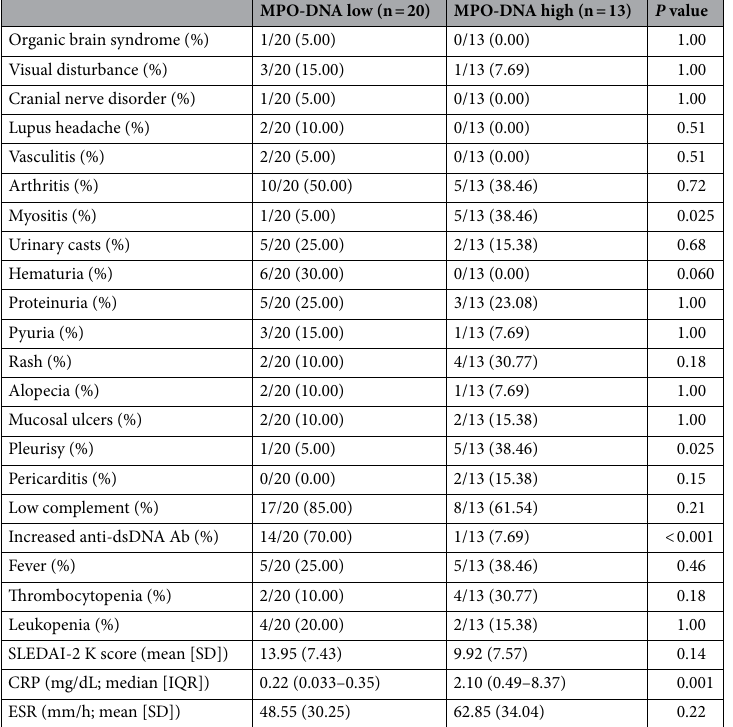
Table 1. Comparison of patients with and without high MPO-DNA complex levels in each SLEDAI-2K variable. The MPO-DNA high group was defined as OD value > 0.62 (mean + 2SD of HC). Group differences in the proportion of categorical variables were analyzed using Fisher’s exact tests. Anti-dsDNA Ab anti-double stranded DNA antibody, CRP C-reactive protein, ESR erythrocyte sedimentation rate, HC healthy control, MPO-DNA myeloperoxidase-DNA, OD optical density, SD standard deviation, SLEDAI-2K systemic lupus erythematosus disease activity index